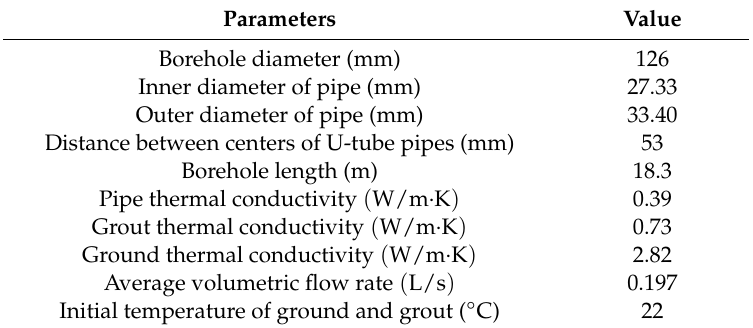
Table 5. Geometric and thermal properties for the experimental test of Beier et al.